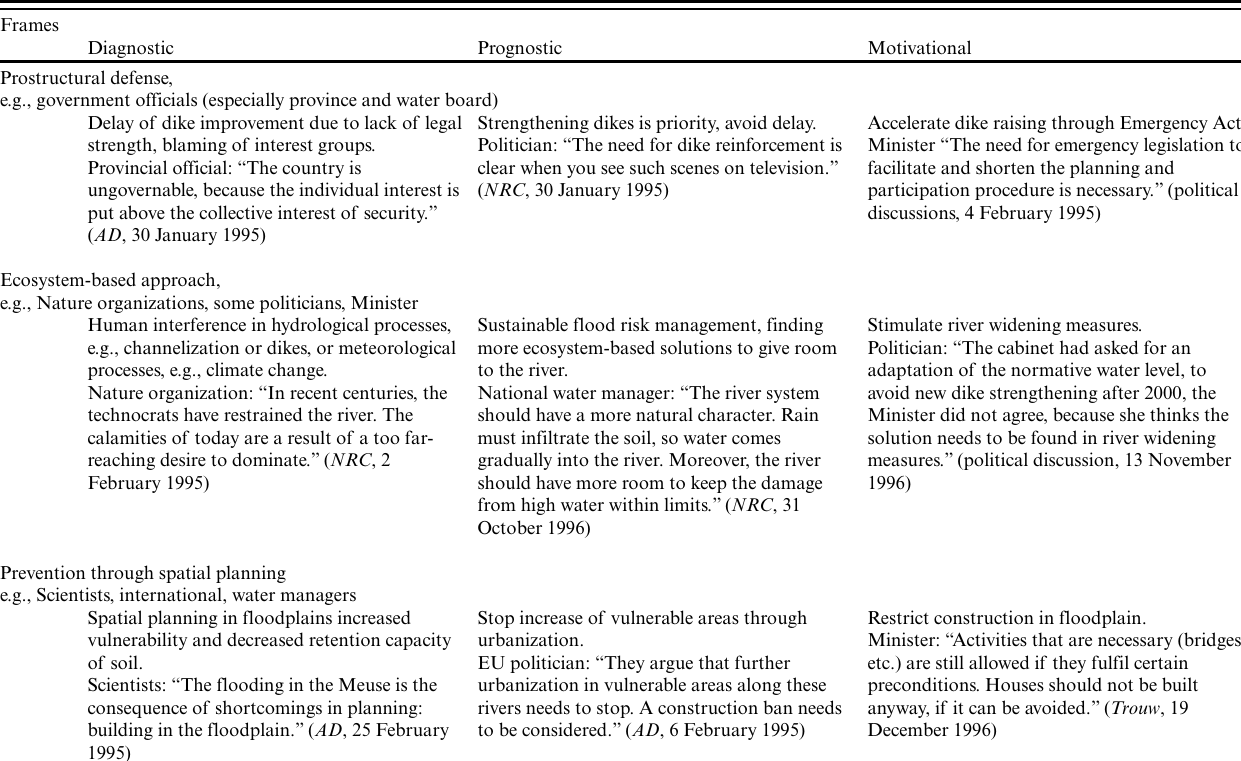
Table 5 . Overview of frames identified after the flood of 1995 with representative quotations